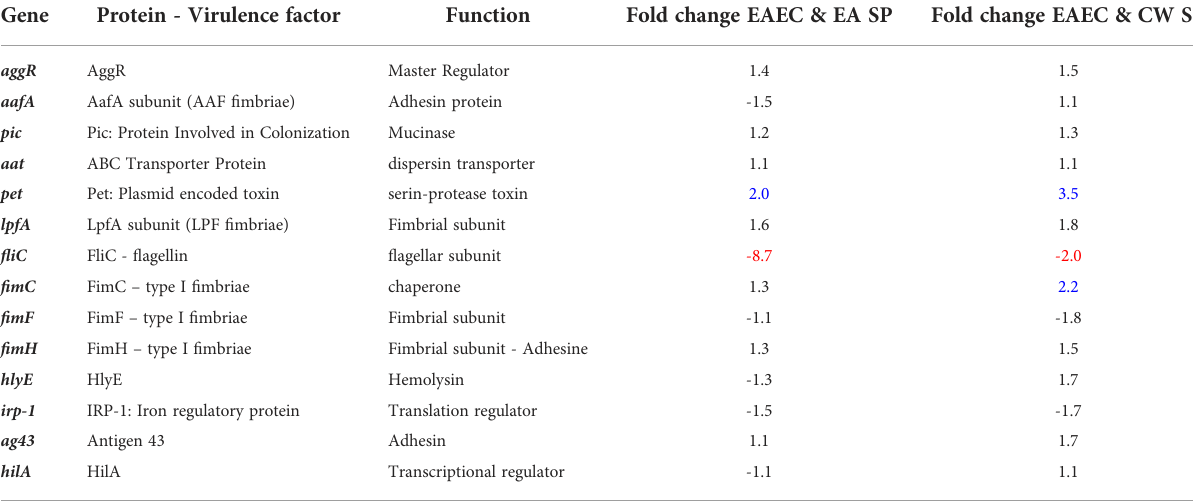
TABLE 2 Changes in gene expression for the main virulence factors in EAEC.